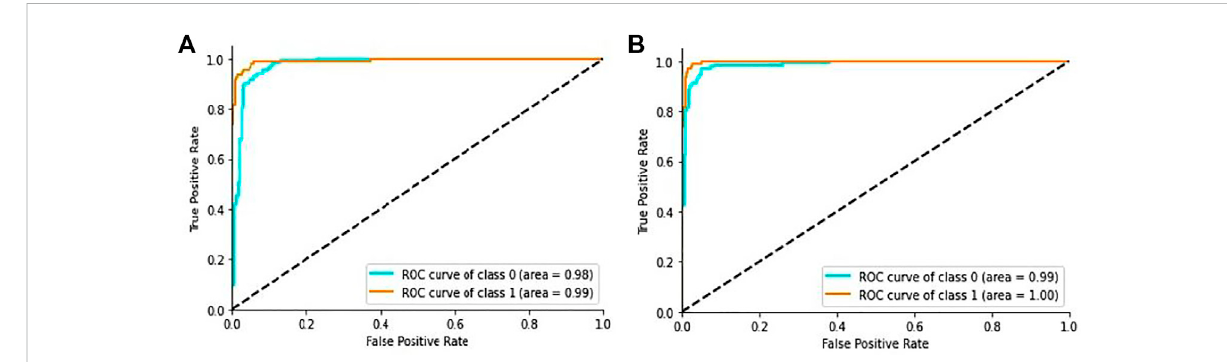
FIGURE 7 ROC curve of the proposed model: (A) ROC curve on CT scan images, (B) ROC curve on X-ray images.